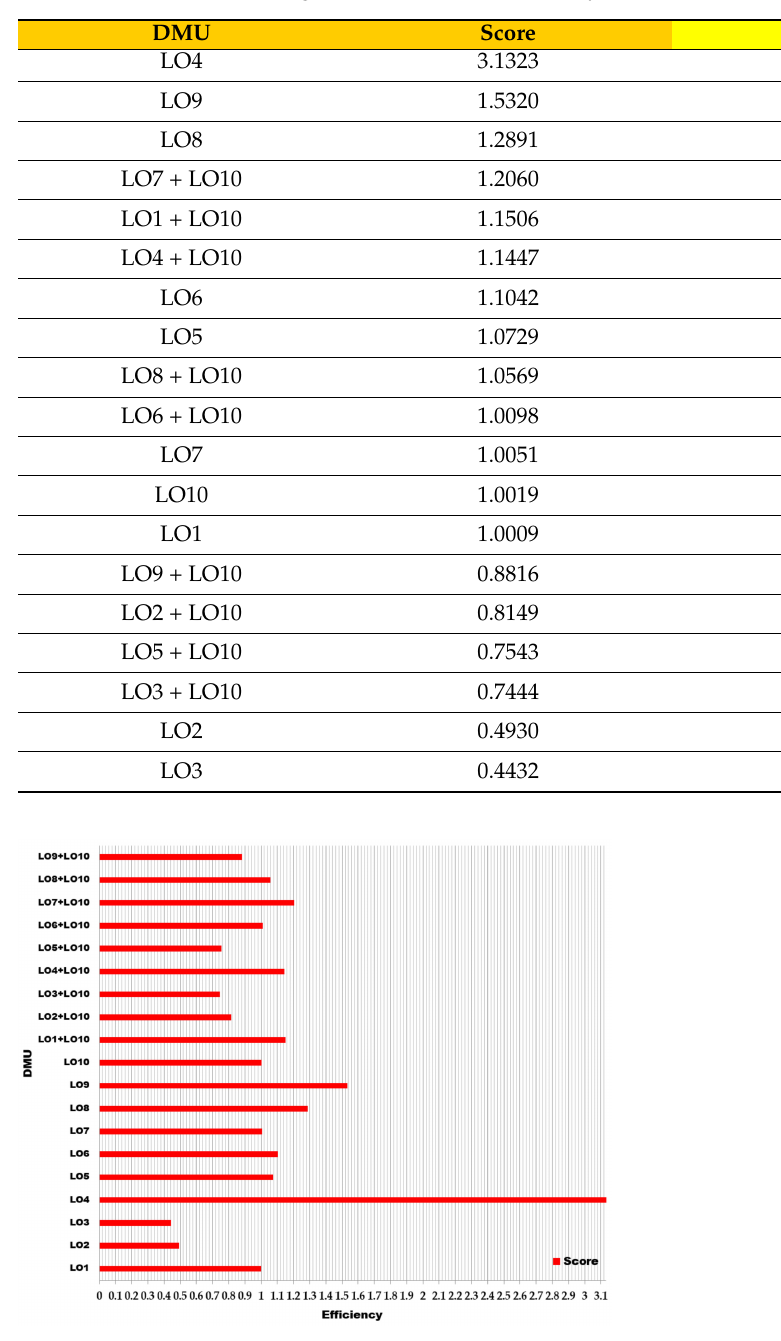
Table 9. Performance ranking of virtual LOs (calculated by researcher).